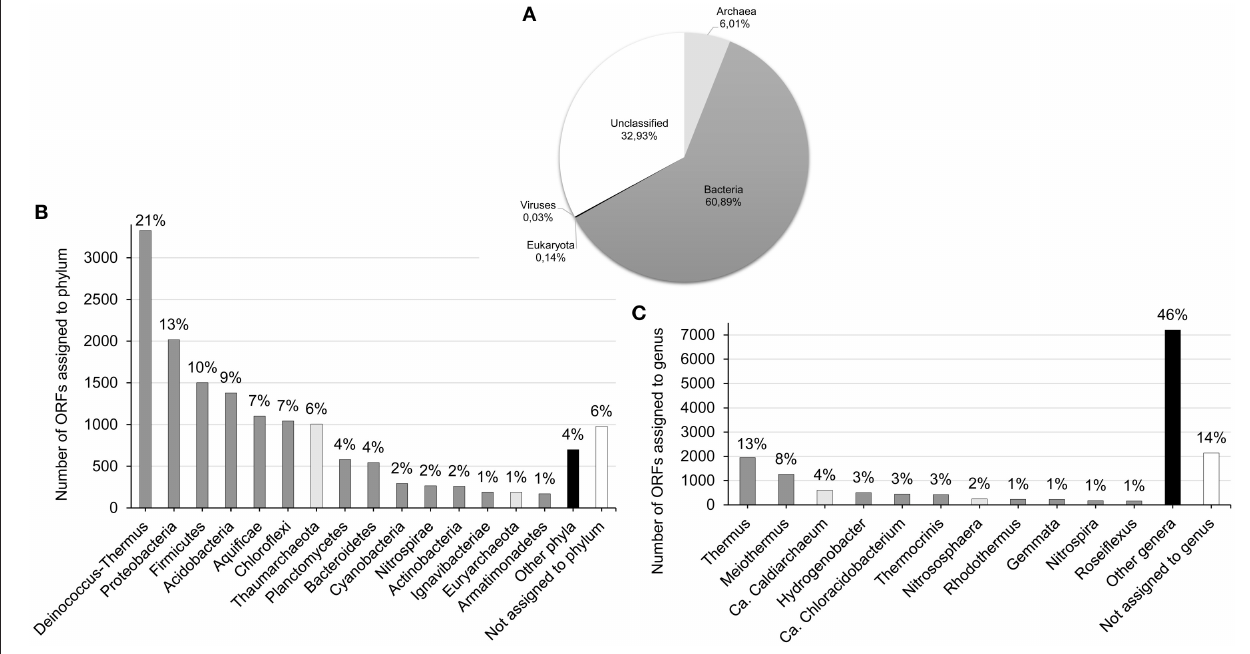
Frontiers in Microbiology |